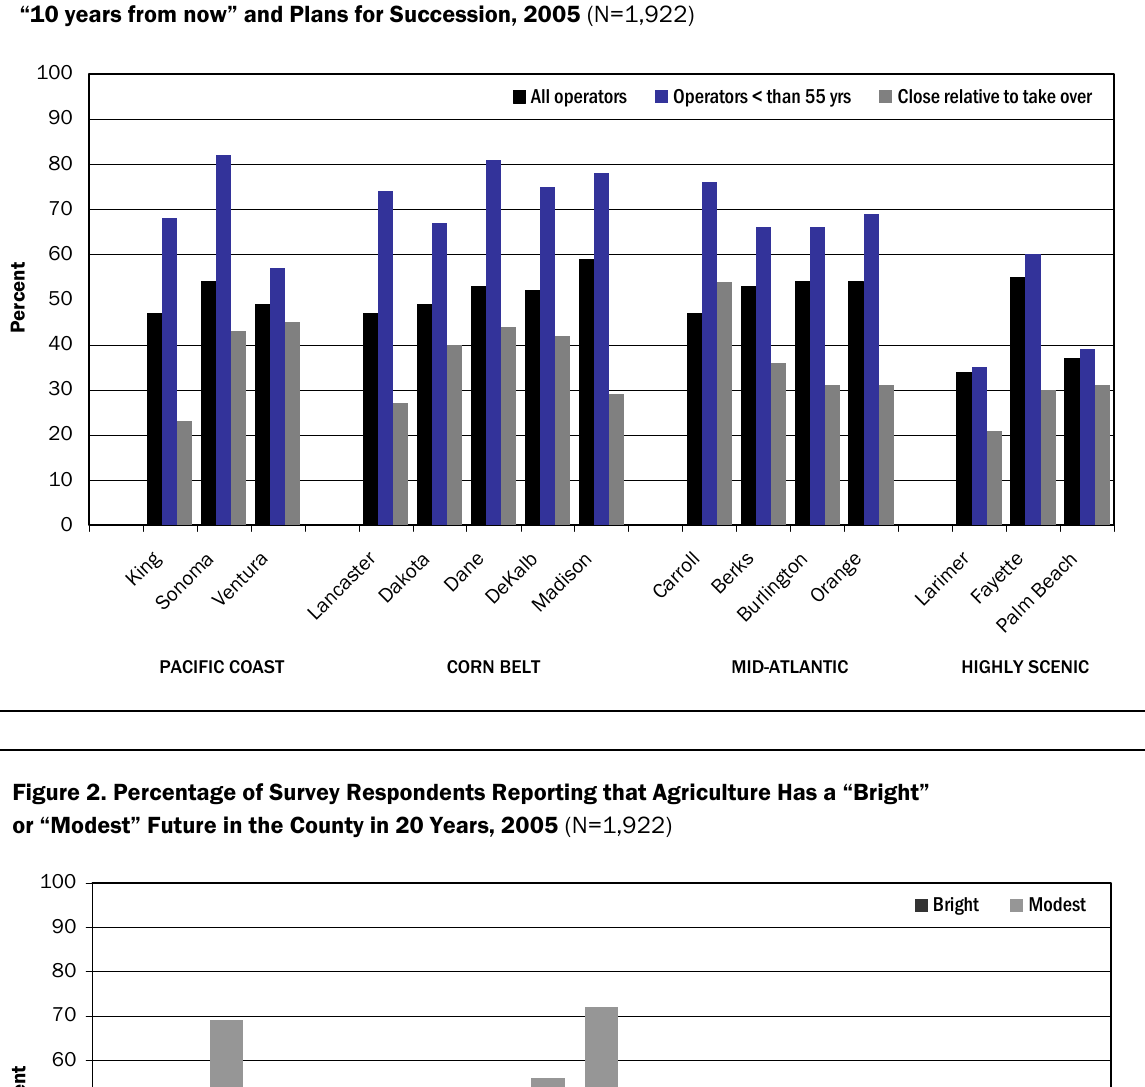
Figure 1. Percentage of Survey Respondents Expecting to be Farming “10 years from now” and Plans for Succession, 2005 (N=1,922)